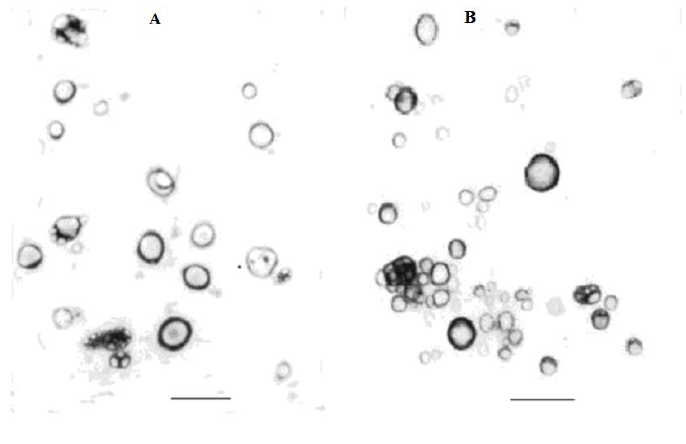
Figure 1. TEM profile of liposomes. ( A ) Profile of complex liposomes suspension; ( B ) Profile of freeze-dried complex liposomes. The bar in the figures represents 400 nm. The amplification time was 25 × 10 3